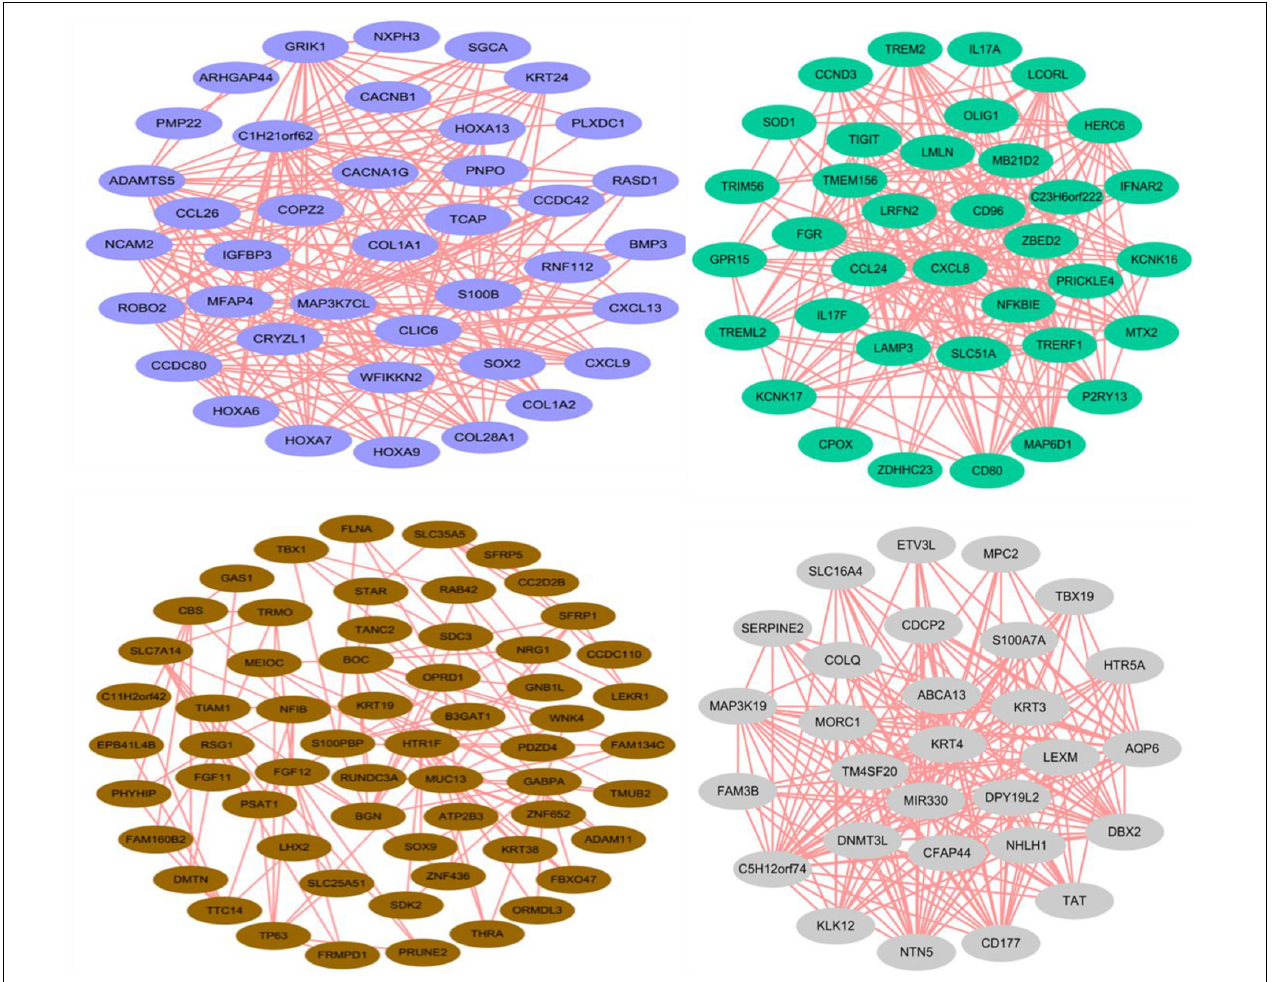
FIGURE 4 | Coexpression networks of core genes in blue, brown, green, and gray60 modules. Each color represents a